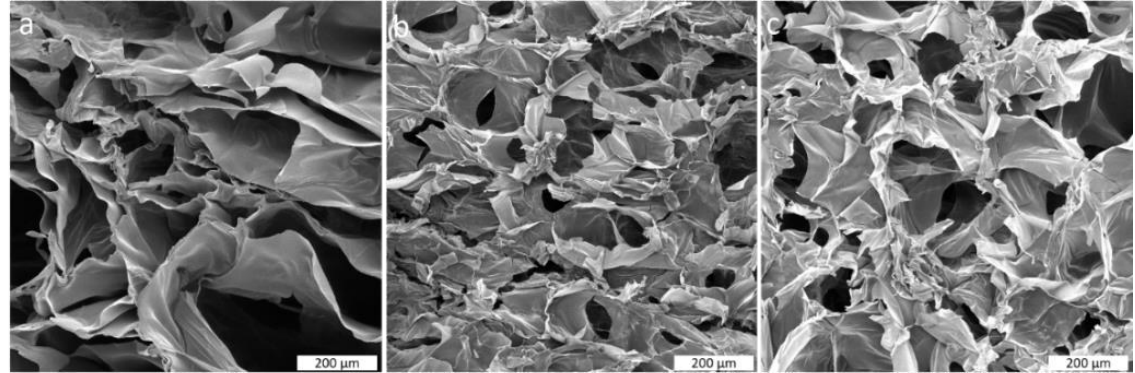
Figure 3. SEM micrograph of ( a ) CHT BA0, ( b ) CHT BA10, and ( c ) CHT BA20 scaffolds. Scale bar: 200 µ